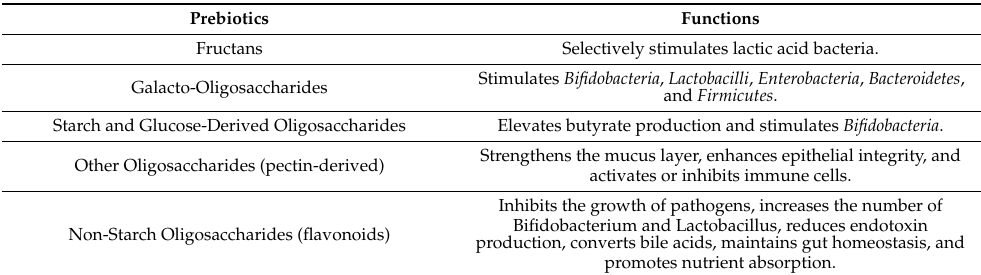
Table 1. Common types of prebiotics and their functions. Prebiotics Functions Fructans Selectively stimulates lactic acid bacteria. Galacto-Oligosaccharides Stimulates Bifidobacteria , Lactobacilli , Enterobacteria , Bacteroidetes , and Firmicutes . Starch and Glucose-Derived Oligosaccharides Elevates butyrate production and stimulates Bifidobacteria . Strengthens the mucus layer, enhances epithelial integrity, and Other Oligosaccharides (pectin-derived) activates or inhibits immune cells. Inhibits the growth of pathogens, increases the number of Bifidobacterium and Lactobacillus, reduces endotoxin Non-Starch Oligosaccharides (flavonoids) production, converts bile acids, maintains gut homeostasis, and promotes nutrient